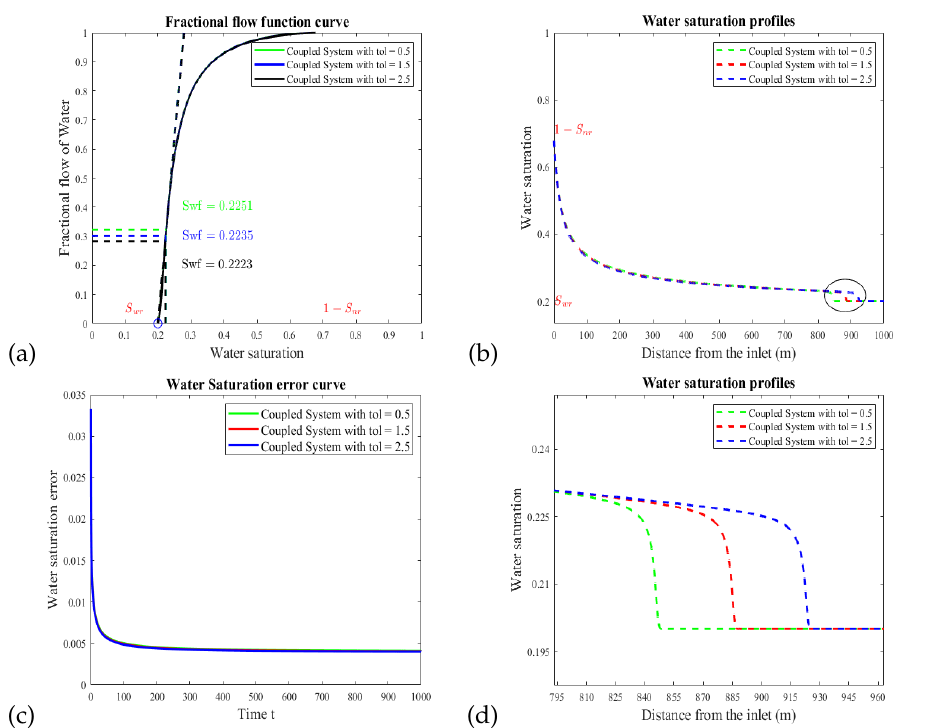
Figure 6. One-dimensional linear: ( a ) water fractional flow f w ; ( b , d ) water saturation S w at front; and ( c ) the water saturation error curve showing the convergence after 1000